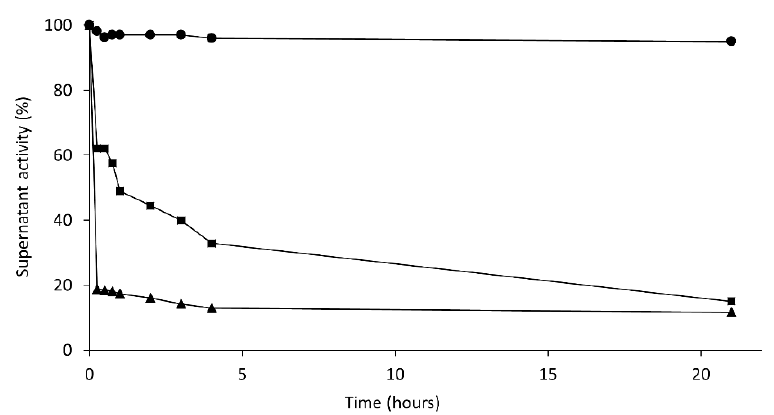
Figure 6. Time-course of immobilization of Lecitase on PEI-agarose. 100% activity of the soluble enzyme before immobilization (in the presence or absence of CTAB). Circles: activity of enzyme solutions without supports; squares: activity of the supernatant of the immobilization suspension in the presence of CTAB; triangles: activity of the supernatant of the immobilization suspension in the absence of CTAB. Since the activity of the enzyme solution remained unaltered for 20 h, the decay of activity in the immobilization suspension can be exactly associated with the percentage of soluble enzyme that became immobilized.